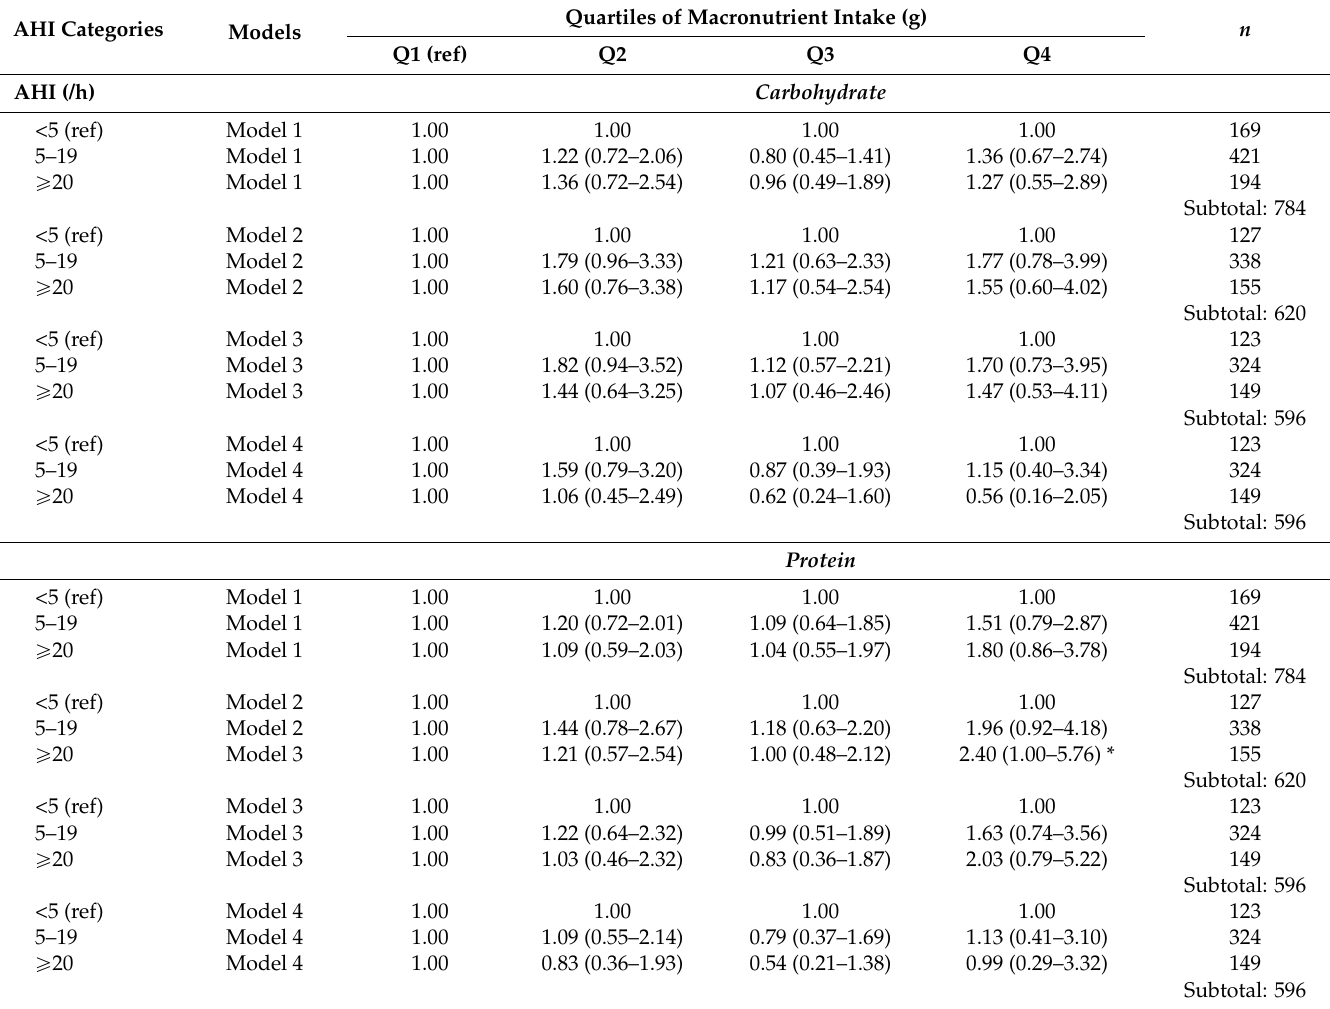
Table 4. The associations between macronutrient intake and Apnoea hypopnea index (AHI) 1